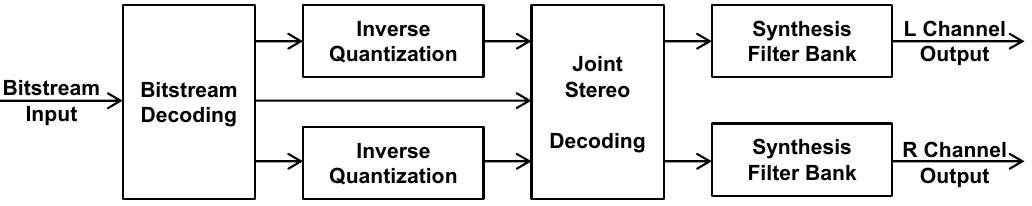
Figure 6. Encoder with Joint Stereo Processing.